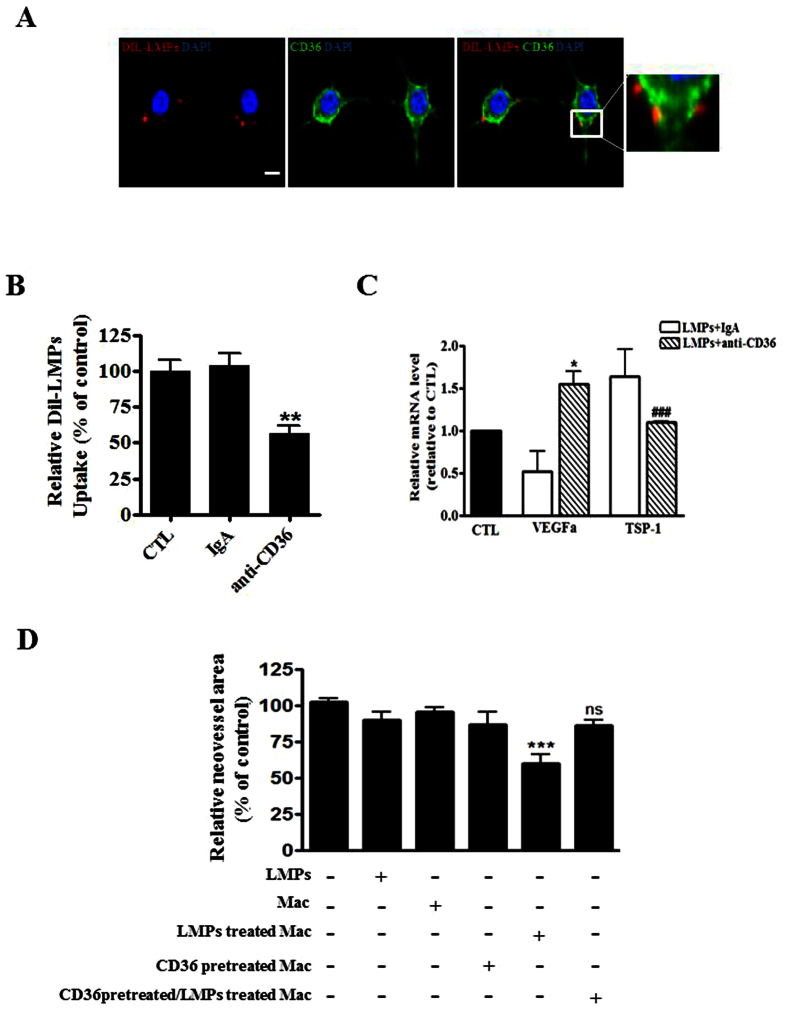
CD36 was involved in the uptake of LMPs by macrophages and mediated the effect of LMPs.(A) Representative images of immunohistochemistry staining of CD36 (in green) and localization of LMPs in macrophages (RAW 264.7) after 4 hours of incubation with DiI-LMPs (in red). Bar: 25 μm. The merged images on the right indicate the co-localization of CD36 and LMPs. (B) After a 4 h incubation of DiI-LMPs (10 μg/ml) with macrophages (control), the isotype-matched control antibody pre-treated (IgA) macrophages, or anti-CD36 antibody pre-treated macrophages, the uptake of DiI-LMPs was measured and expressed as percentage of control (CTL, set as 100%). **P < 0.01 anti-CD36 vs. CTL. (C) RAW 264.7 were pre-treated with control antibody (IgA) or anti-CD36 before 24 hours LMPs treatment. The mRNA levels of VEGFa and TSP-1 in the macrophages were determined by quantitative PCR. *P < 0.05, ###P < 0.001 vs. LMPs + IgA. (D) The RPE-free choroidal explants were cultured for developing new vessels in the first 5 days, and then explants were incubated for another 48 hours with 50 μg/mL of LMPs, macrophages RAW 264.7(Mac), LMPs-treated Mac, anti-CD36 pre-treated Mac or anti-CD36 pre-treated + LMPs-treated Mac. The neovascularized areas in each condition were measured and presented as a percentage of control (explants without any treatment set as 100%). ***P < 0.001 vs. CTL.